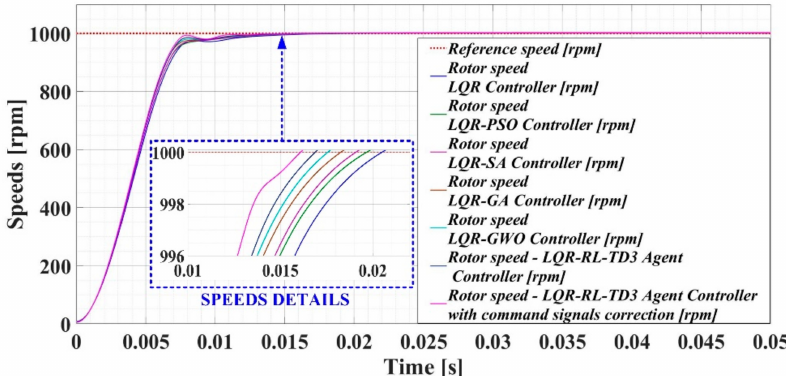
Figure 13. Comparison of the time evolution of speed for PMSM–CS–CI based on the LQR-type